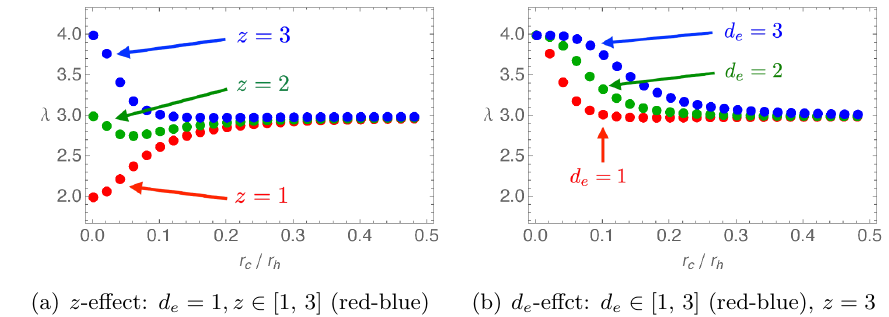
Figure 4 . The power λ vs. r c /r h . The numerical result interpolating two (analytic) limiting cases: λ = 1 + z in eq. (3.6) at small cutoff and λ = 3 in eq. (3.7) at large